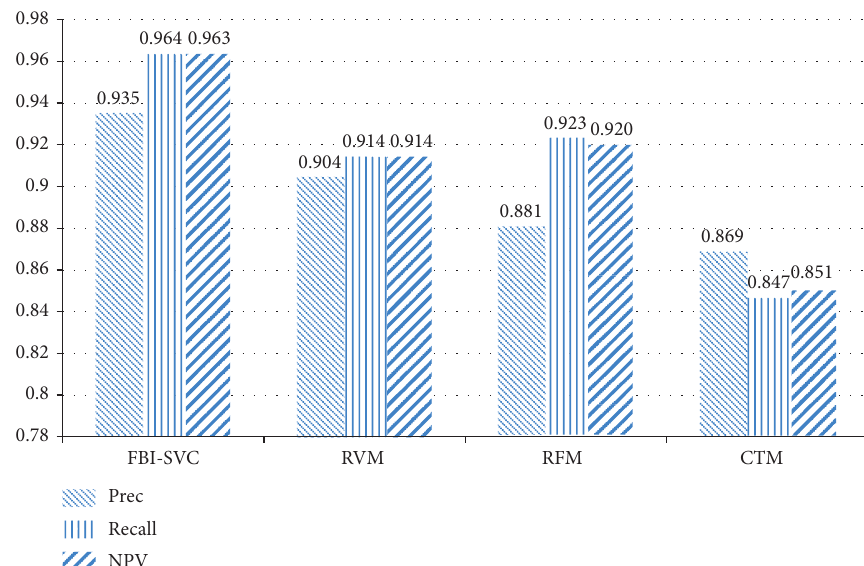
Figure 10: Performance comparison with respect to precision, recall, and NPV.